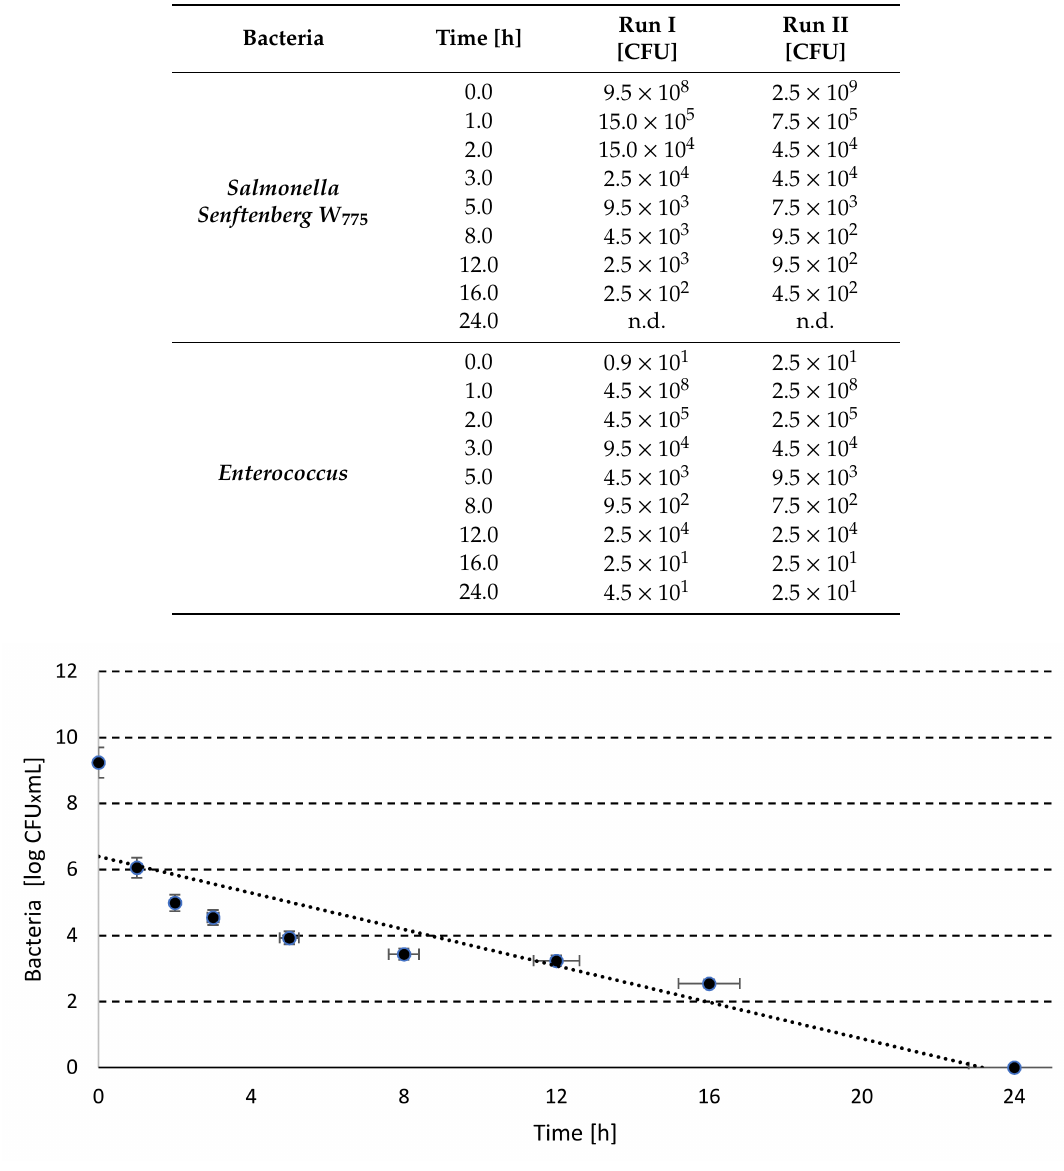
Table 1. Colony formed units (CFU) of analyzed bacteria in laboratory scale.